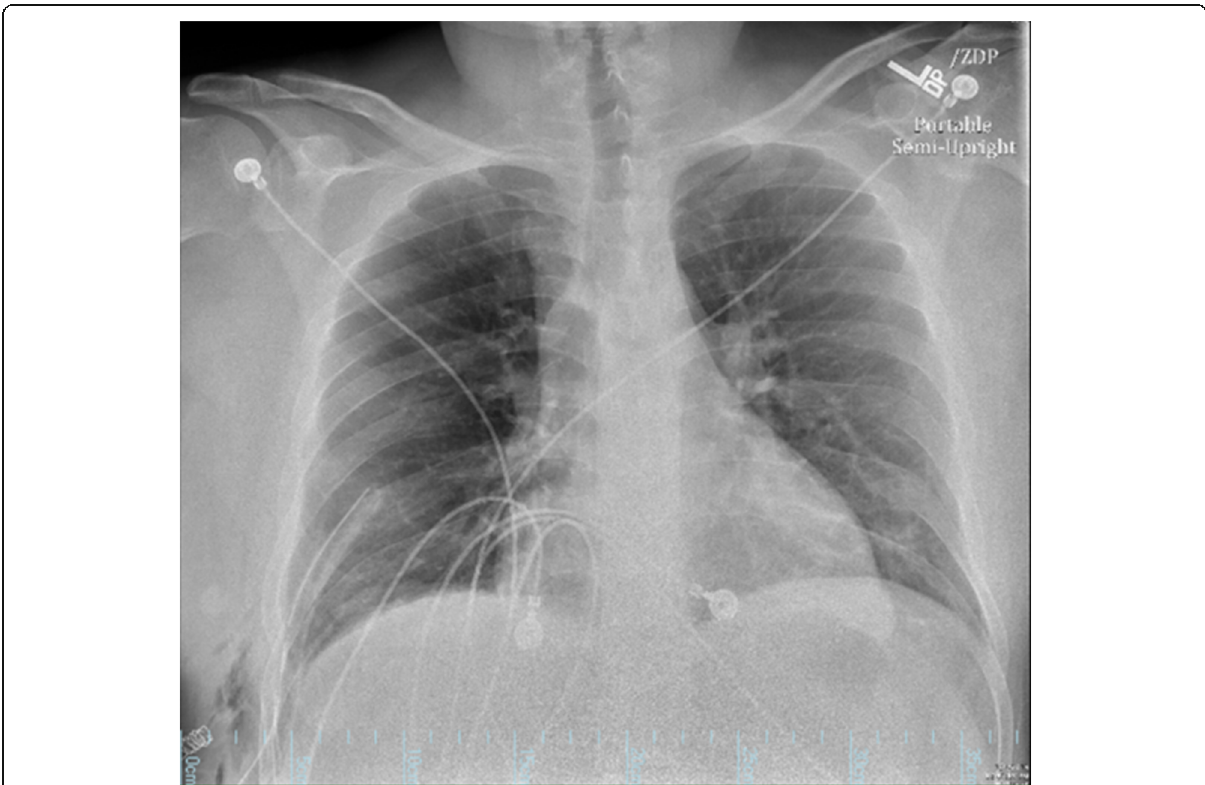
Fig. 6 Post-operative chest radiograph showing good diaphragmatic repair and no remaining intrathoracic